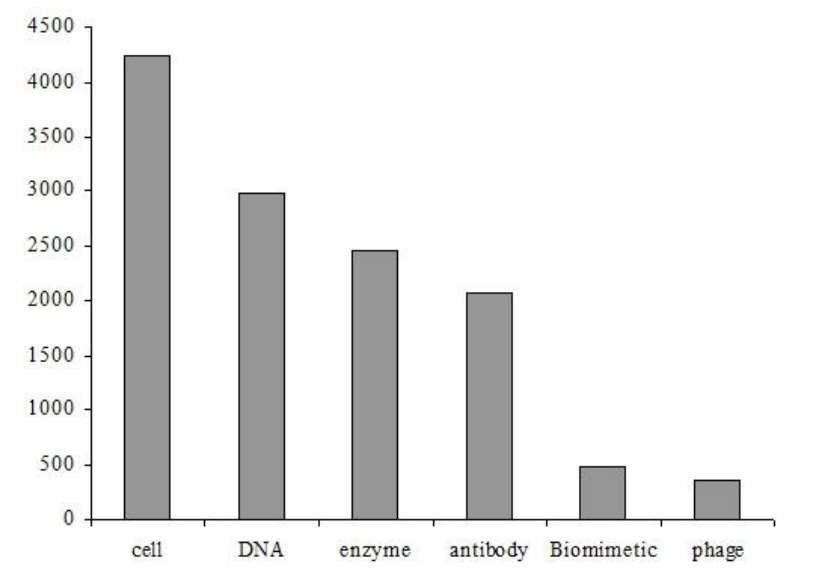
Figure 2. Analysis of the biosensor literature containing the terms ‘CMOS’ or ‘integrated circuit’, (data source: ISI Web of Knowledge and Google Scholar, 3rd February